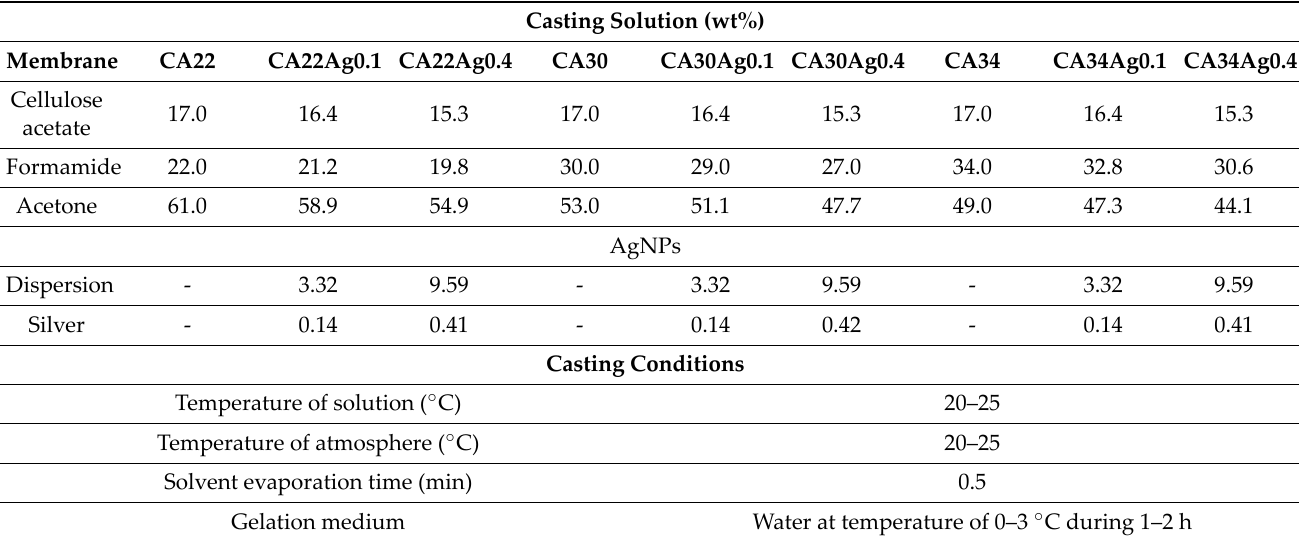
Table 1. Casting solutions compositions and film casting conditions of the CA membranes free of silver (CA22, CA30, and CA34), with 0.1wt% Ag (CA22Ag0.1, CA30Ag0.1, and CA34Ag0.1) and